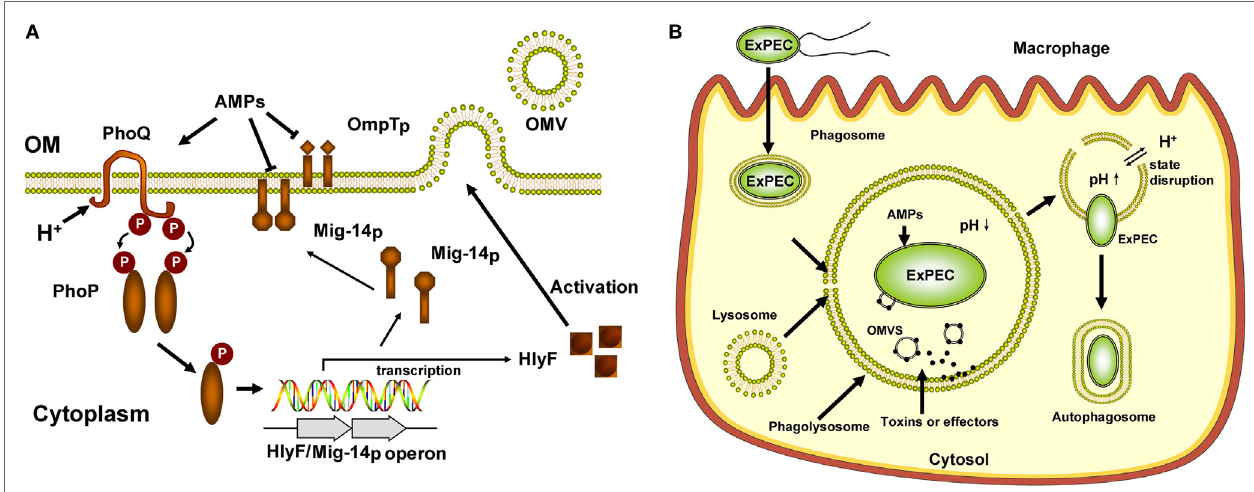
FigUre 8 | Illustration of PhoP/PhoQ-regulated phenotypes modulating extraintestinal pathogenic Escherichia coli (ExPEC) intracellular trafficking in macrophages. (a) Summary of PhoP/PhoQ-regulated phenotypes in ExPEC. In response to critical components of bacterial killing within macrophages, PhoQ was activated by CAMPs and acidic pH for ExPEC survival within macrophage phagolysosomes. The activated PhoQ enhances the phosphorylation level of PhoP, and phosphorylated PhoP enhanced its binding affinity for P hlyF promoter to upregulate the transcription of HlyF and Mig-14p (a novel PhoP regulon). Mig-14p, located in inner membrane, conferred ExPEC resistance to CAMPs. Mig-14p and OmpTp inhibited the penetration of bacterial membrane by CAMPs. PhoP/PhoQ triggered outer membrane vesicles (OMVs) biogenesis and controls the production of ExPEC OMVs by upregulating the HlyF expression. (B) Model of ExPEC intracellular trafficking in macrophages. ExPEC was internalized by phagocytosis. The ExPEC-containing phagosomes fused with lysosomes phagolysosomes. PhoP/ PhoQ-HlyF signaling pathway regulated the production of ExPEC OMVs, and OMVs might play critical roles in ExPEC to prevent bacterial-containing phagolysosomal fusion and phagolysosomal acidification. ExPEC OMVs contain some unknown toxins and effectors, which might be associated with ExPEC-containing phagolysosomal membrane disruption. PhoP/PhoQ-HlyF pathway promoted the escape of ExPEC from phagolysosomes and entry into macrophage cytosol and facilitated the formation of ExPEC-containing autophagosome. ExPEC might hijack the autophagy to promote its intracellular